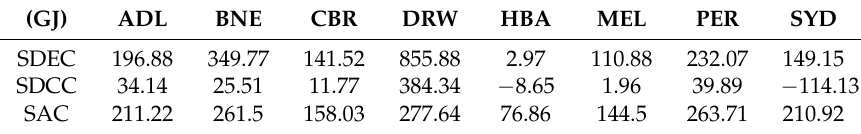
Table 9. Annual HVAC electricity savings for the solar-assisted cooling systems. (GJ) ADL BNE CBR DRW HBA